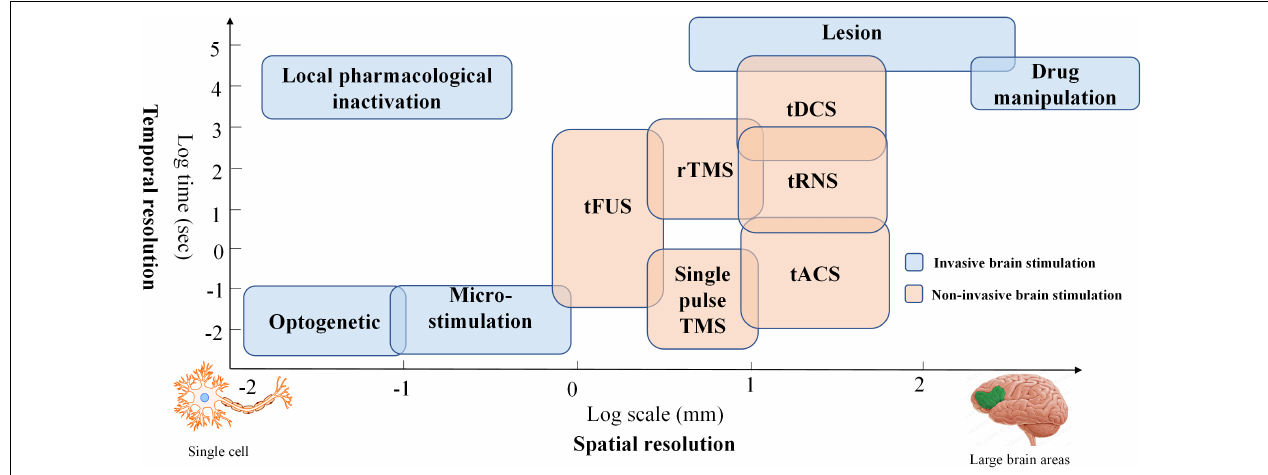
FIGURE 1 | Temporal and spatial resolution of various brain intervention methods: Blue boxes represent invasive brain stimulation techniques, and orange boxes denote non-invasive stimulation methods.